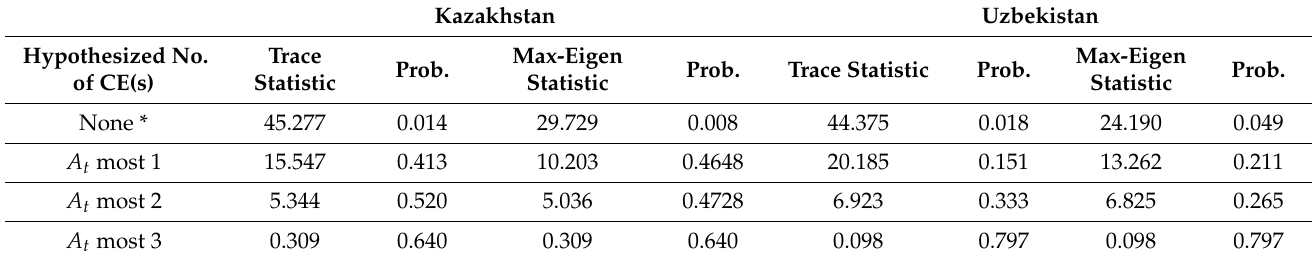
Table 3. Co-integration test results.